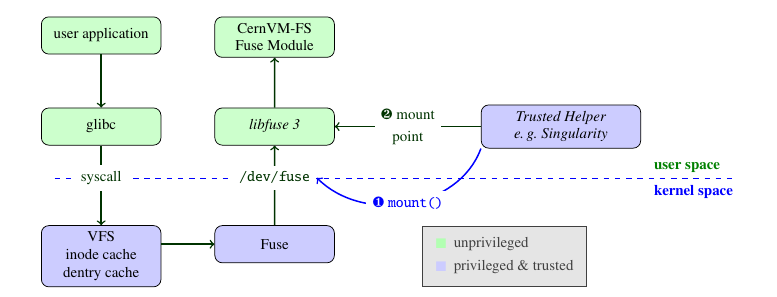
Figure 2. As in Fuse vanilla deployments, a privileged helper program takes care of mounting the file system. But in contrast to Fuse version 2, in Fuse version 3 this program can be a custom one di ff erent from / bin / fusermount.